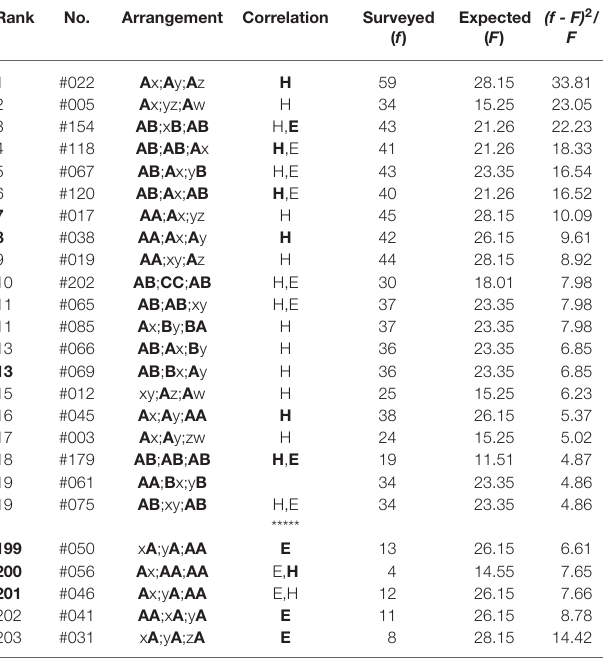
TABLE 7 | The top-twenty and the bottom-five arrangements in the first three TABLE 5 | The top-twenty arrangements in The Complete Haiku Works of Seishi phrases (5-7-5) of poems in Collection of Ten Thousand Leaves , wherein there are Yamaguchi, wherein there are 8523 poems included. 4183 tanka poems included. Rank No. Arrangement Correlation Surveyed ( f ) Rank No. Arrangement